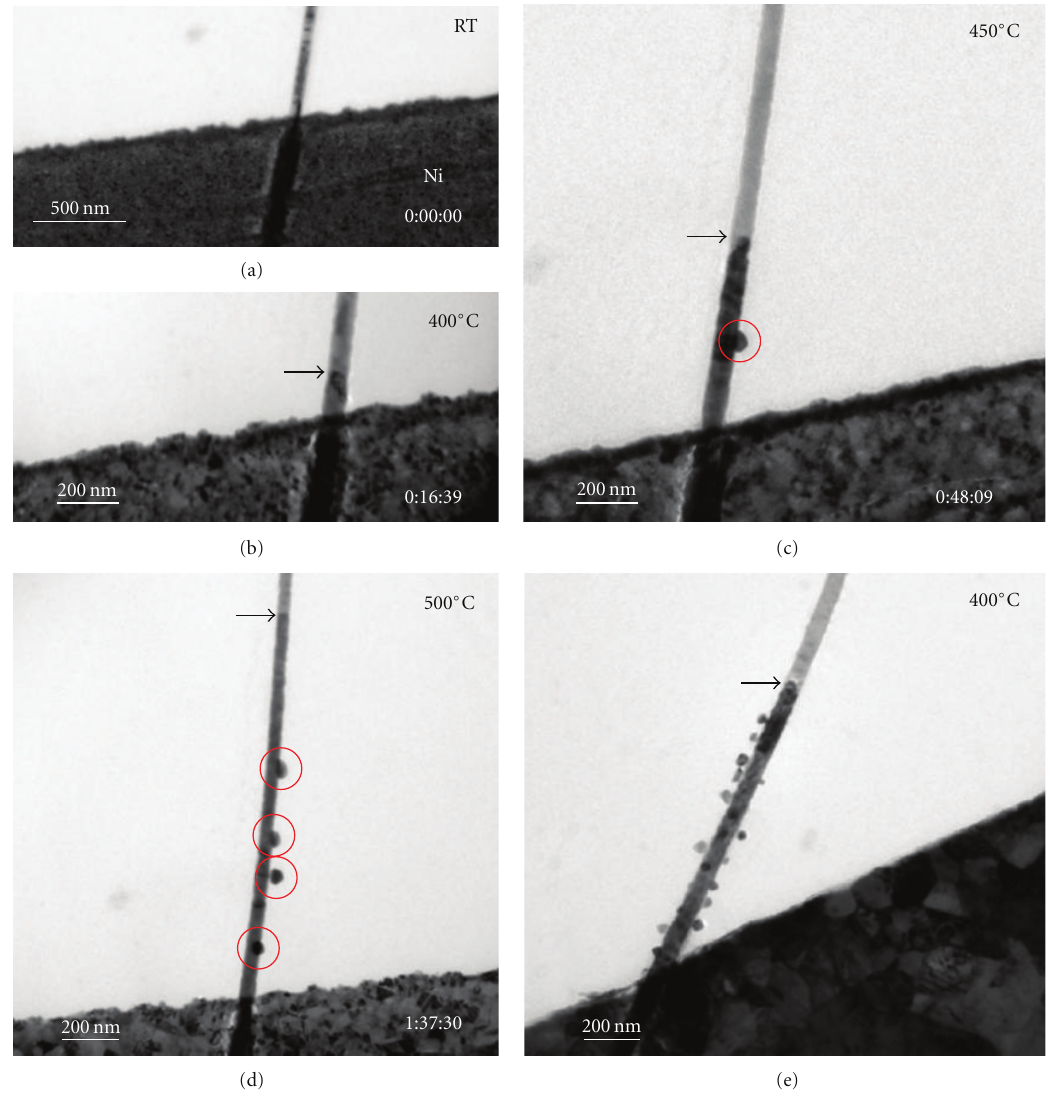
Figure 4: A series of in situ TEM images at various annealing temperatures: (a) room temperature; (b) 400 ◦ C; (c) 450 ◦ C; (d) 500 ◦ C. The arrows indicate the interface between the formed Ni 2 Ge and the Ge nanowire. The red circles indicate Ni 2 Ge nanoparticles segregated from the Ni 2 Ge nanowire. (e) TEM image of the Ni electrode reacted with a Ge nanowire upon 400 ◦ C annealing for 30 min. Reproduced from